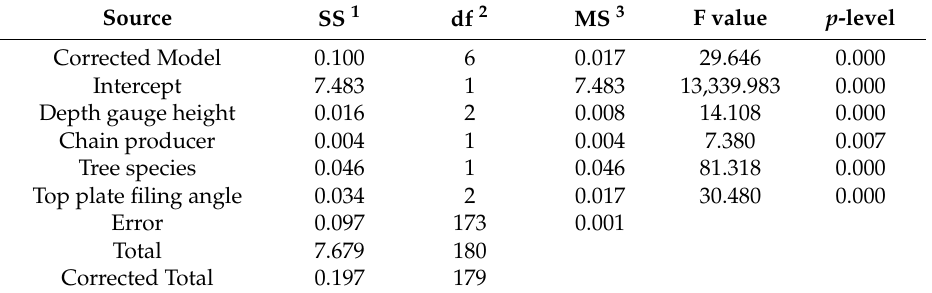
Table 2. ANOVA results between cross cutting time (square root transformed) and independent